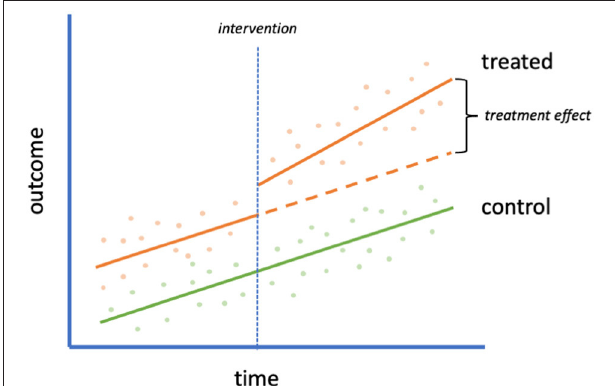
FIGURE 2 | Interrupted time series with control group. An example of an interrupted time series design with control group (often analyzed with a difference-in-differences approach). A scatterplot of data is shown with an intervention (orange) and control (green) group. The intervention is implemented in the treated group at the time of the vertical dotted line. The orange dashed line refers to the hypothetical outcome of the treated group in the absence of the intervention. The difference between this hypothetical outcome and the actual outcome is the treatment